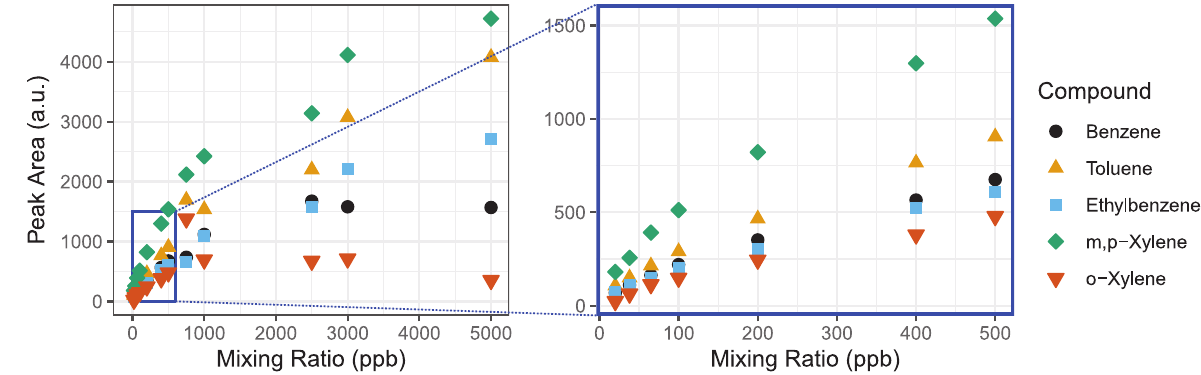
Figure 4. We evaluate the detection range of the BTEX GC-PID system by measuring a wide range of mixing ratios until an asymptote is reached. The detection linear range (0–500 ppb) is magnified highlighted by the blue box. The R 2 values for linear fits to each compound are all greater than